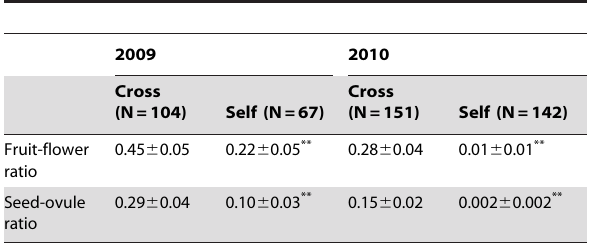
Table 2. Fruit and seed production in hand-pollination experiments in C. trichotomum